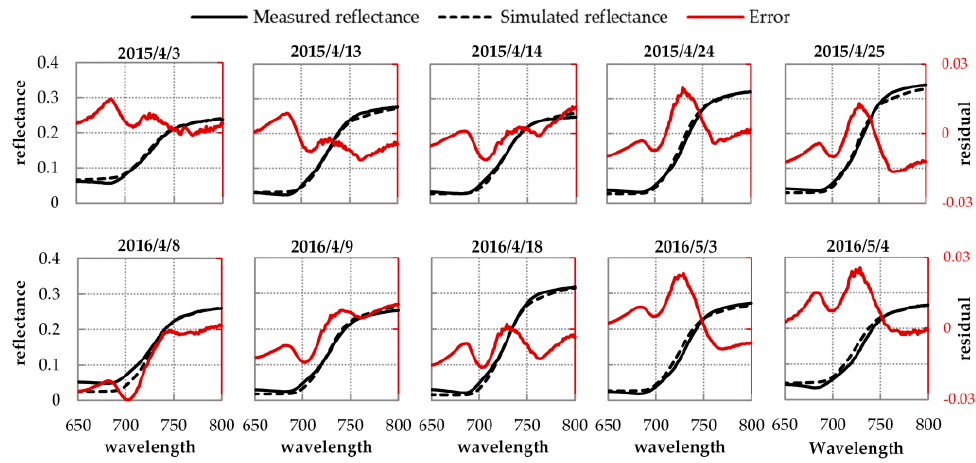
Figure 5. The simulated and measured reflectance spectra and their residuals at 10:00 for every fieldwork day in 2015 and 2016.